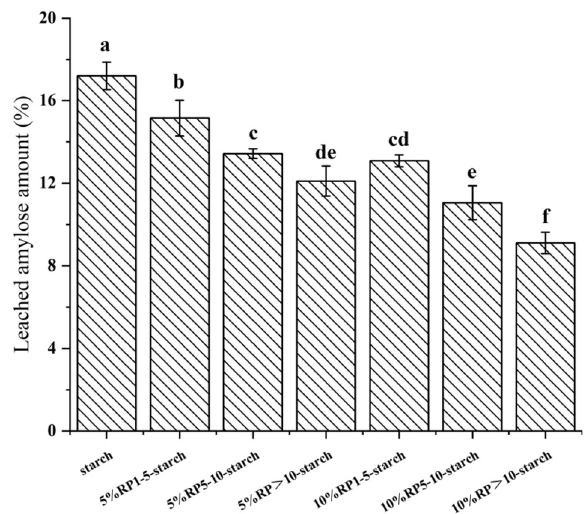
Fig. 1 The leached amylose amounts of native starch and RP- starch mixtures. The error bars on the bar charts represented the standard deviations. Column diagrams with different letters indicated signi fi cant difference ( p <